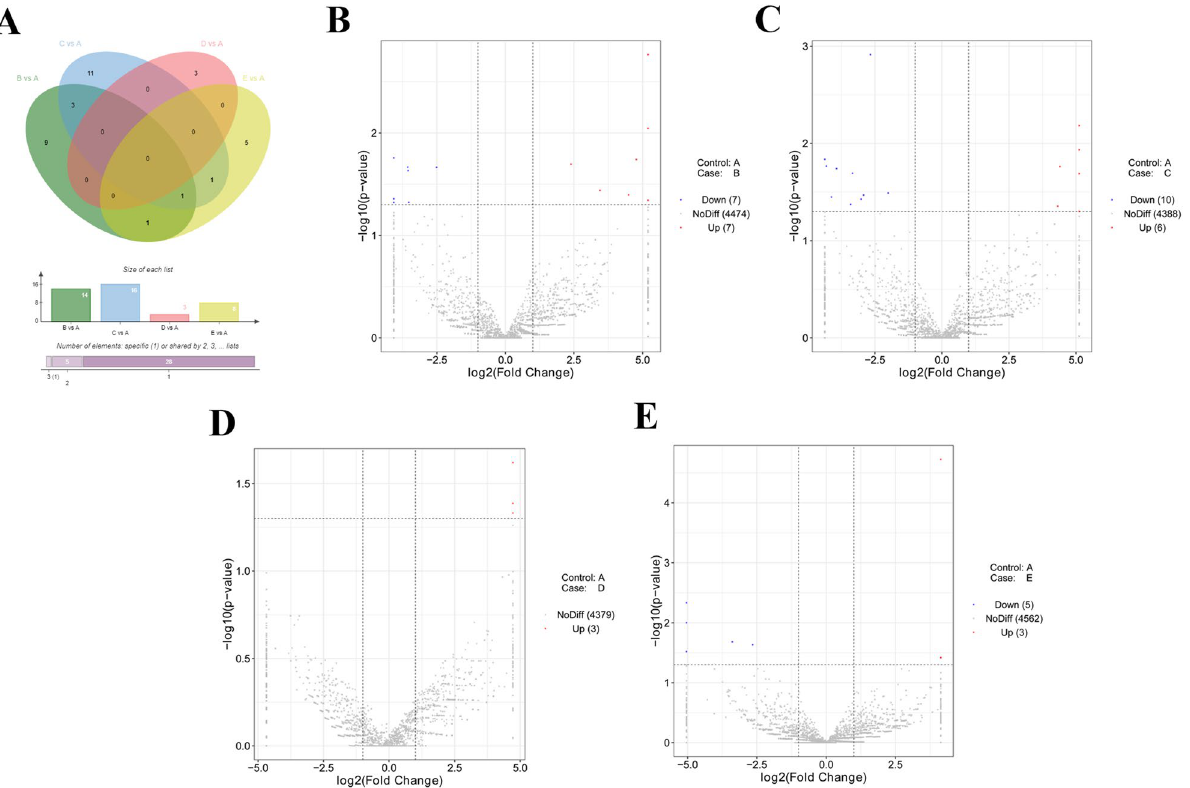
Figure 1. Identification of DE circRNAs. ( A ) Venn diagram of DE circRNAs in B vs A, C vs A, D vs A, and E vs A groups. ( B – E ) Volcano plot of circRNA expression profiles in B vs A ( B ), C vs A ( C ), D vs A ( D ), and E vs A ( E ) groups. Venn plot was drawn by jvenn website (http:// jvenn. toulo use. inra. fr/ app/ examp le. html) 51